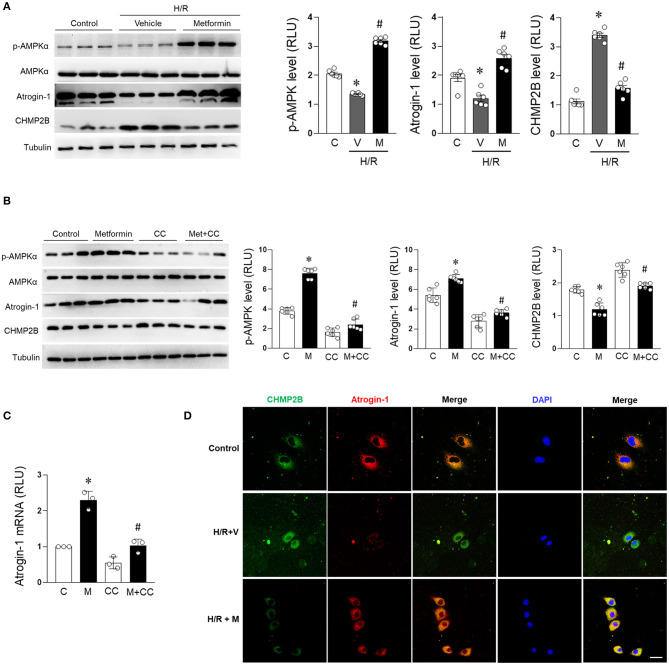
Metformin prevents CHMP2B accumulation in H/R-treated cardiomyocytes in AMPK dependent manner. H9c2 cells were treated with metformin (2.5 mmol/L) or vehicle for 12 h and subjected to hypoxia for 15 h followed by reoxygenation for 1 h. (A) Representative immunoblotting and quantification data of p-AMPKα, AMPKα, atrogin-1, and CHMP2B for each group. (B) H9c2 cells were treated with metformin (2.5 mmol/L) or compound C (20 μmol/L) for 12 h. Representative immunoblotting and quantification data of p-AMPKα, AMPKα, atrogin-1, and CHMP2B for each group. (C) Relative mRNA expression levels of atrogin-1 as determined by qRT-PCR. (D) H9c2 cells were treated with metformin (2.5 mmol/L) or vehicle and simultaneously subjected to hypoxia for 15 h followed by reoxygenation for 1 h. Representative photomicrographs for CHMP2B (green) and atrogin-1 (red) co-localization staining by immunofluorescence. Scale bar = 50 μM. Values are means ± SEM, n = 6 per group. Except as otherwise noted, *p ≤ 0.05 vs. control group, #p ≤ 0.05 vs. H/R + vehicle or compound C group.